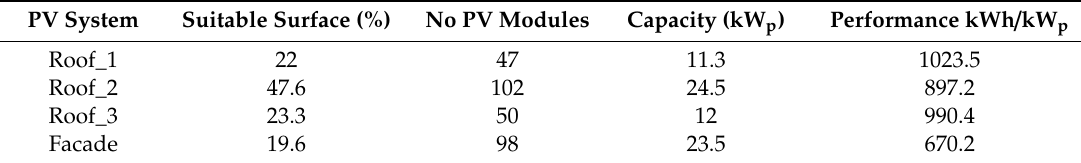
Table 3. Parameters of the designed PV scenarios.